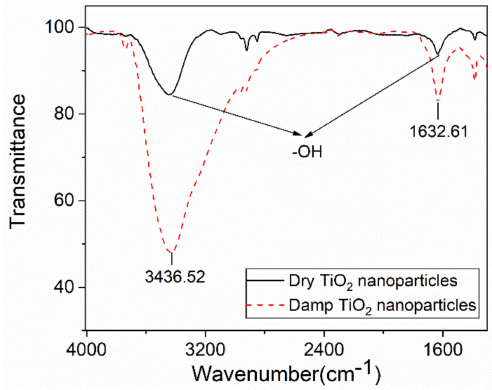
Figure 5. FTIR spectra of TiO 2 nanoparticles.